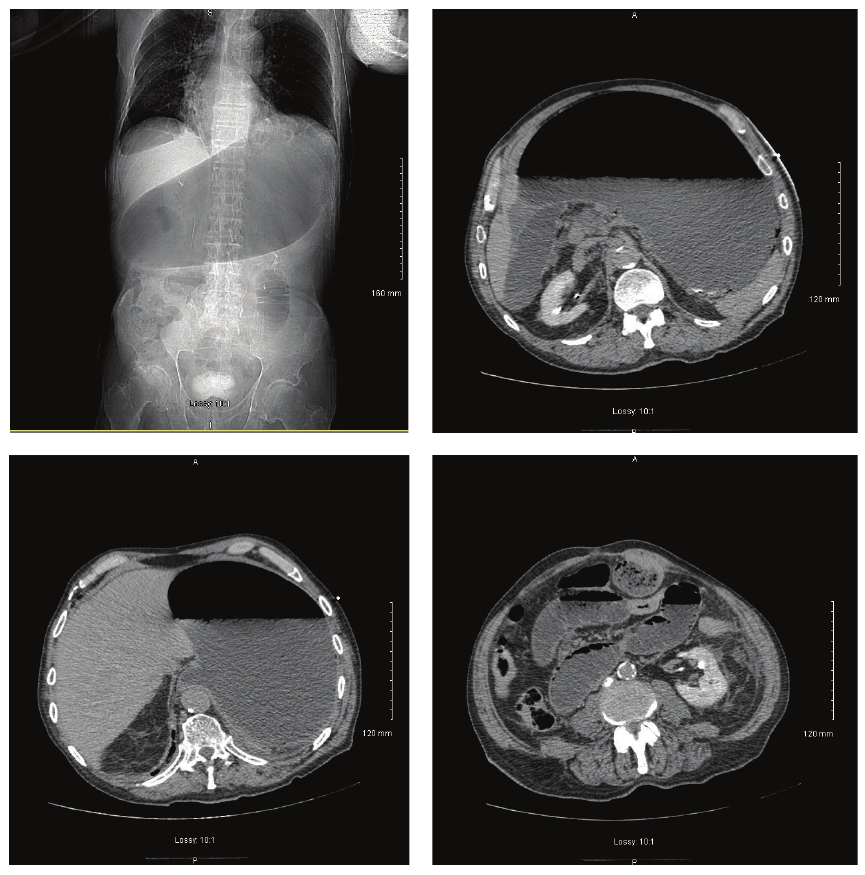
Figure 3: CT scan of the abdomen showing small bowel obstruction, with transition point in the jejunum with a markedly dilated stomach containing foci of air. Also a dilated gall bladder with gallstones and normal-appearing pancreas is noted.